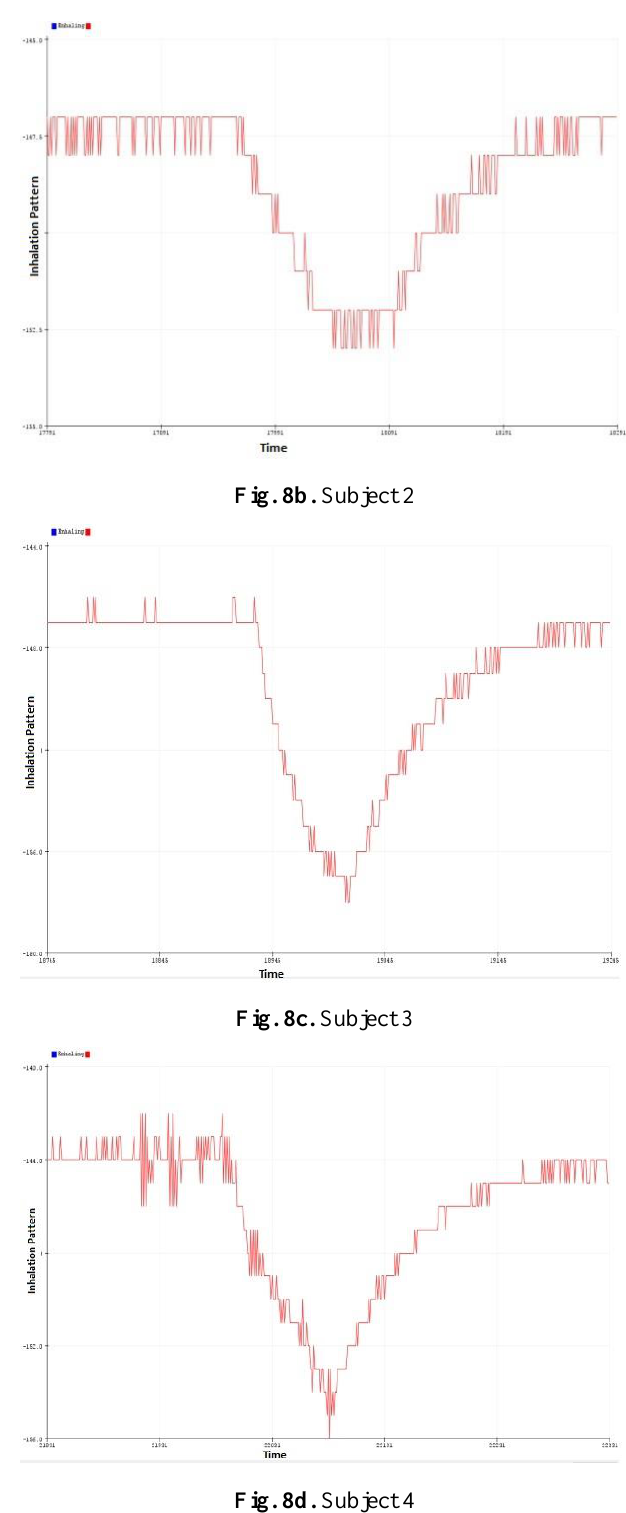
Fig. 8. Variation in-breath or inhalation level of chain smoker to time, which ranges from -140 liters to -162 liters The Fig. 9 shows the variation in inhalation patterns of different conditions including asthmatic participants, hypertensive individuals, smokers, and non-smokers with normal individuals. It is evident that chain smokers have adverse breathing patterns than smokers and hypertensive patients. Moreover, it is also evident from the bar chart that the inhalation pattern of